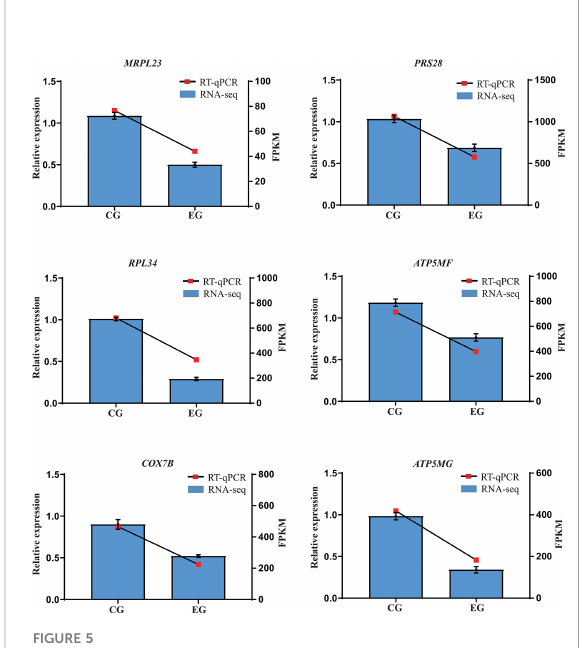
FIGURE 5 Relative expression levels from RT-qPCR. CG, control group (non-challenged with pathogenic E. coli O88); EG, experiment group (challenged with pathogenic E. coli O88). Data are indicated as means ± SEM ( n = 6). The relative expression values were normalized to the b -actin gene. RPS28 , ribosomal protein S28; MRPL23 , mitochondrial ribosomal protein L23; RPL34 , ribosomal protein L34; ATP5MG , ATP synthase membrane subunit g; COX7B , cytochrome c oxidase subunit 7B mitochondrial; ATP5MF , ATP synthase membrane subunit